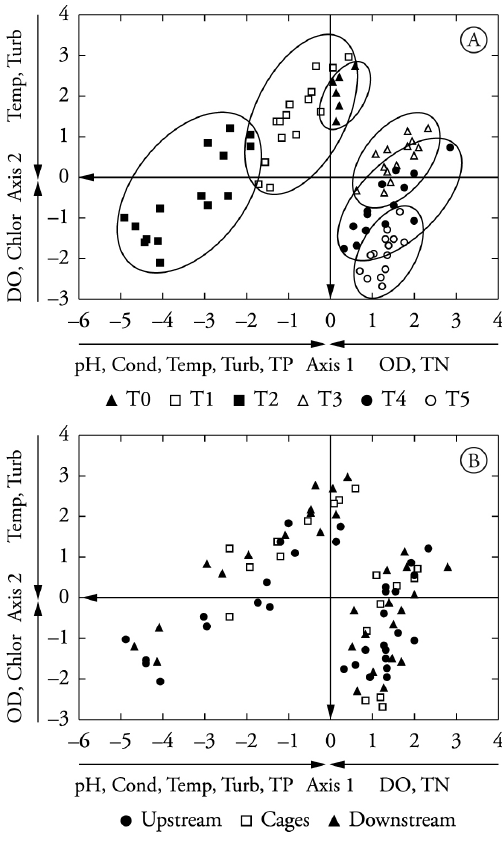
Figure 2. Scores of the Principal Component Analysis (PCA) with dispersion of the environmental variables according to the sampling periods (A) and points (B). Environmental variables: Temp = temperature; Turb = turbidity; DO = dissolved oxygen; Cond = conductivity; TP = total phosphorus; TN = total nitrogen; chlor = chlorophyll-a.